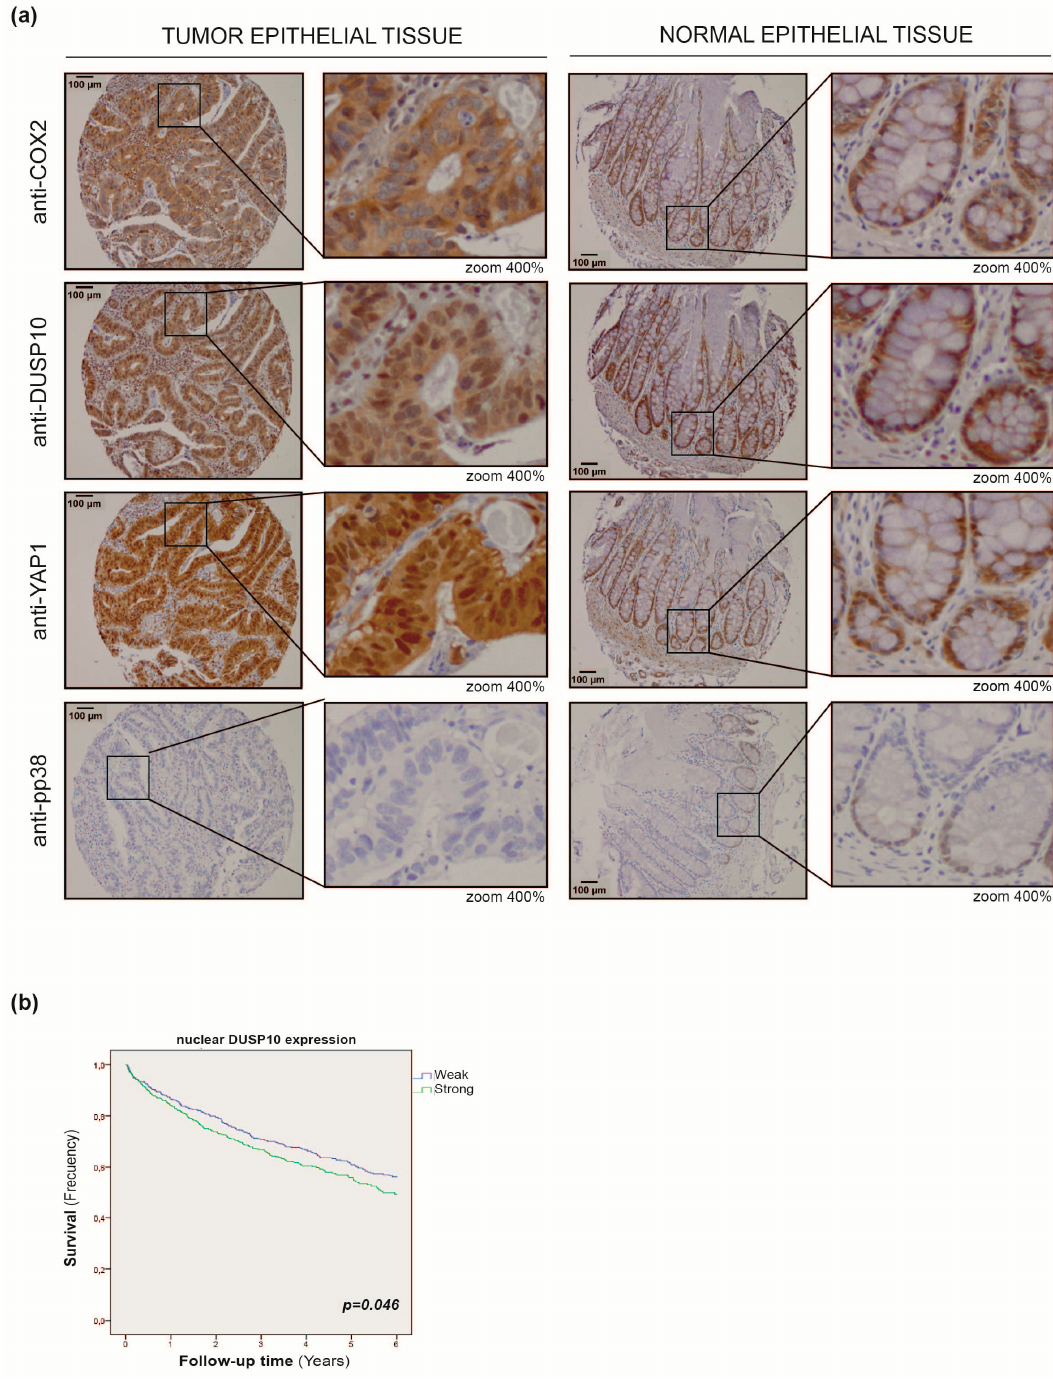
Figure 6. DUSP10 is expressed in colon cancer patients and its nuclear expression is associated with a poor prognosis. ( a ) Representative images of DUSP10, p-p38, and YAP1 staining on a tissue microarray (TMA) in normal epithelial and tumor colon tissue from 73 human patients by immunohistochemistry (IHC). (Left) Image taken at 10 × magnification (Bars, 100 µ m) and (Right) magnified 400% by zoom. ( b ) Kaplan–Meier survival curve ( p < 0.05) of 999 colon cancer patients with weak (blue line) and strong (green line) nuclear DUSP10 expression in tumor epithelial tissue for six years.